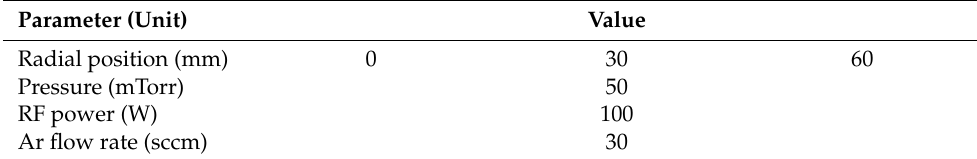
Figure 6. Ion current measurement using LP and IEMS. Table 1. Experimental conditions for radial position change.